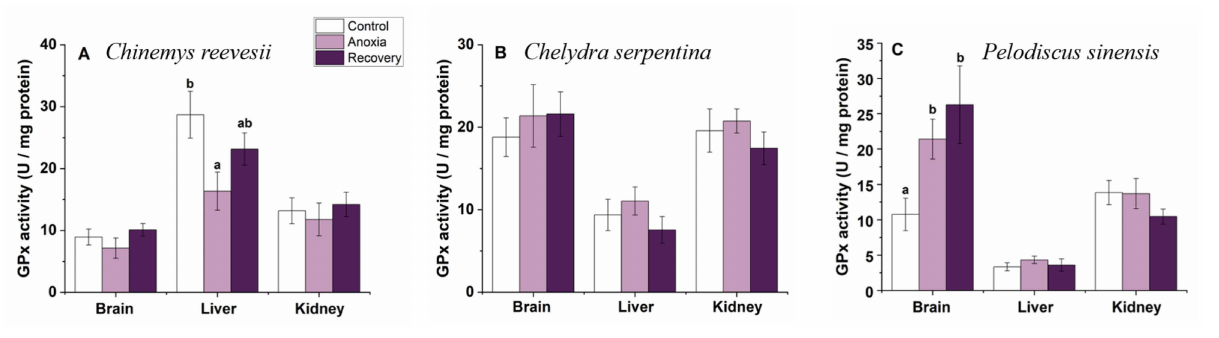
Figure 9. Changes of anoxia stress on GPx activity in tissues of C. reevesii ( A ), C. serpentina ( B ) and P. sinensis ( C ). Data are presented as mean ± SE. N = 10. Data with no common lowercase letters on the bar indicate significant difference between different groups ( p < 0.05).